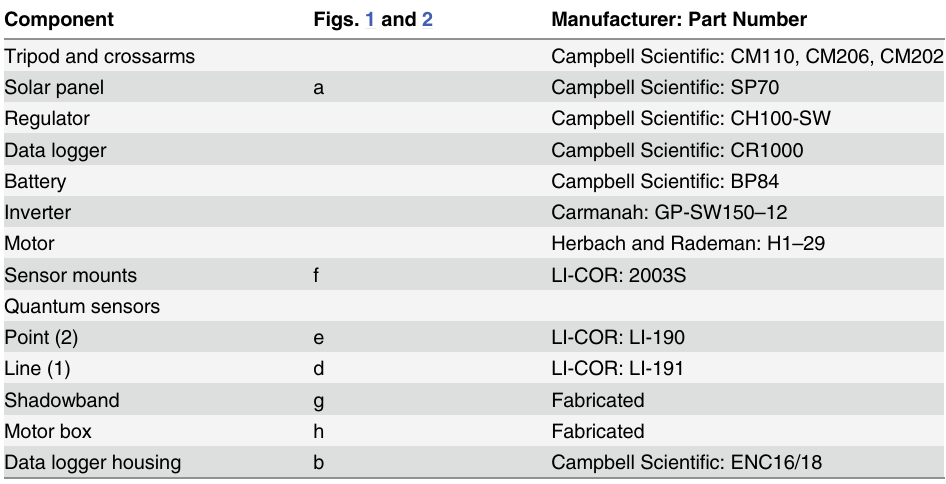
Table 2. List of parts for shadowband